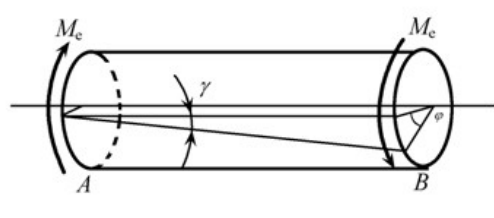
Fig. 7 Torsional deformation of